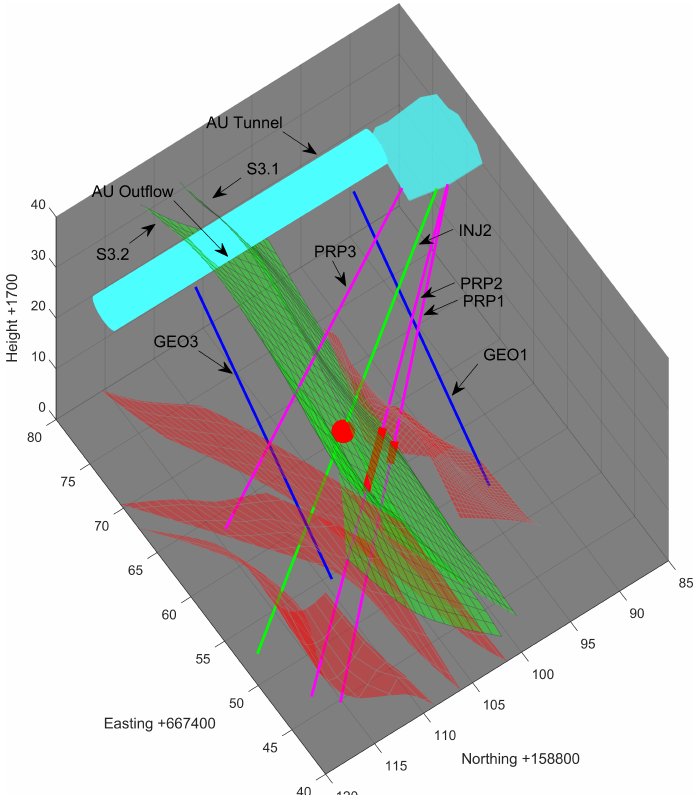
Figure 5. Geological model of the experiment volume with relevant structures and boreholes. The S1 and S3 shear zones are shown in red and green, respectively. The GPR survey was performed in the blue GEO boreholes. The salt tracer injection point is indicated as a red sphere. Monitoring intervals in the PRP boreholes are indicated in